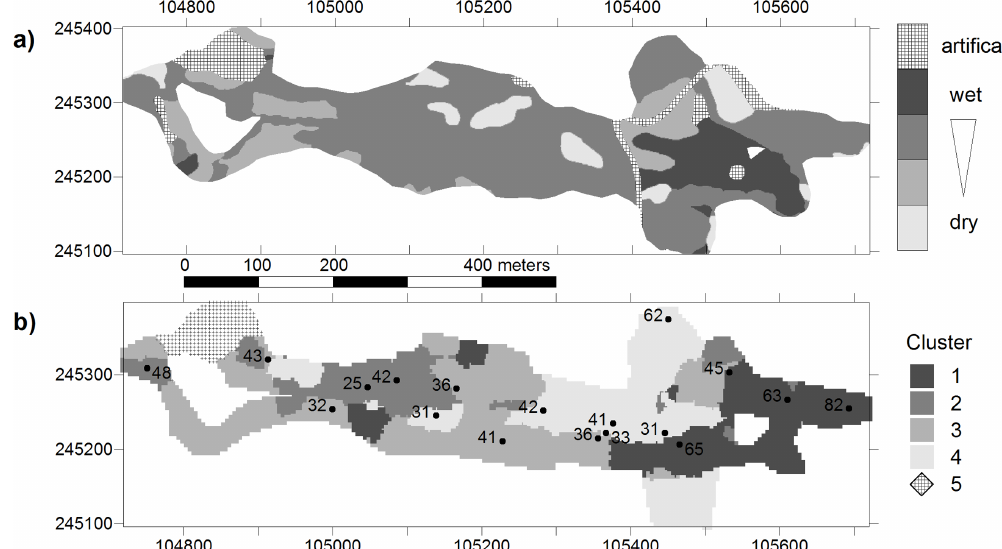
Fig. 7. Detail map of hill-slope partitioning based on (a) the ecological zonation according to Lindenmaier et al. (2005), and (b) the 5-cluster model with locations of the soil samples. The numbers denote the determined soil-water contents. The different shades of grey in both maps indicate the different ecological classes and clusters, respectively. Coordinates on x- and y-axis are in metric BMN M28 Austrian coordinate system.